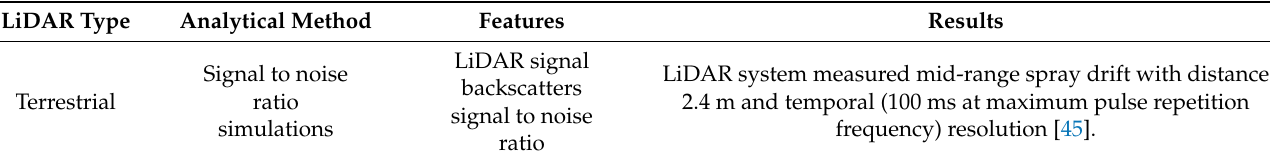
Table 6. Comparison of various aspects of LiDAR data in spray drift